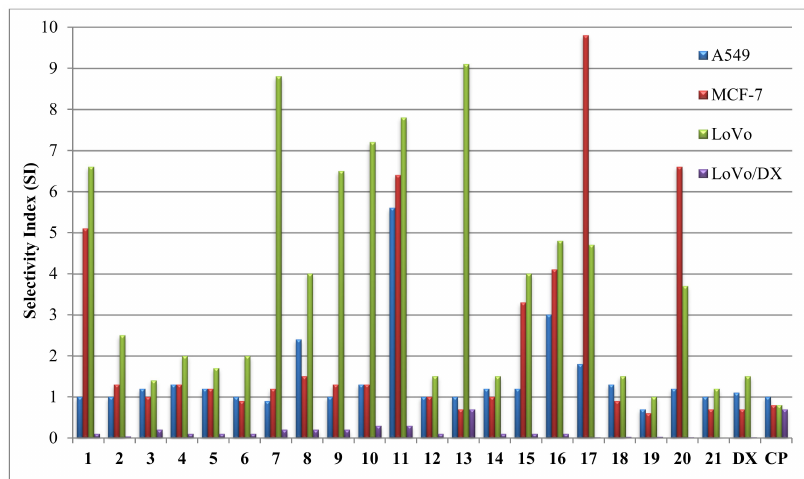
Figure 3. Comparison of selectivity index (SI) values of the tested compounds. The SI was calculated for each compound using the formula: SI = (IC 50 for normal cell line BALB / 3T3) / (IC 50 for respective cancerous cell line). A favorable SI > 1.0 indicates a drug with e ffi cacy against tumor cells greater than the toxicity against normal